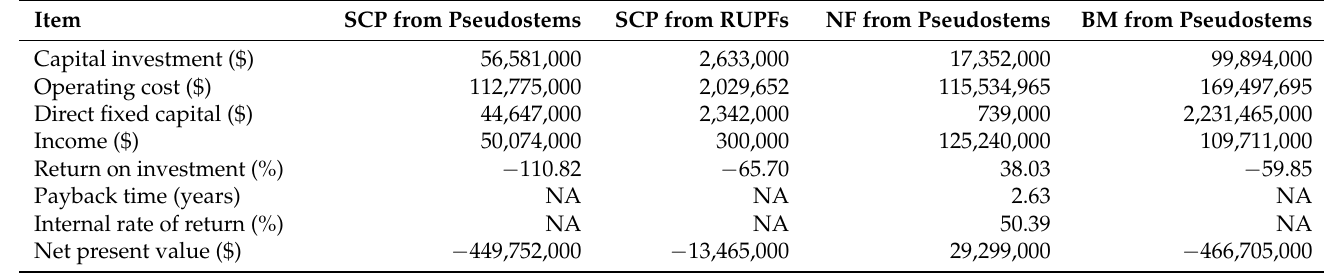
Table 8. Summary of the techno-economic assessment of the simulated process flowsheets.